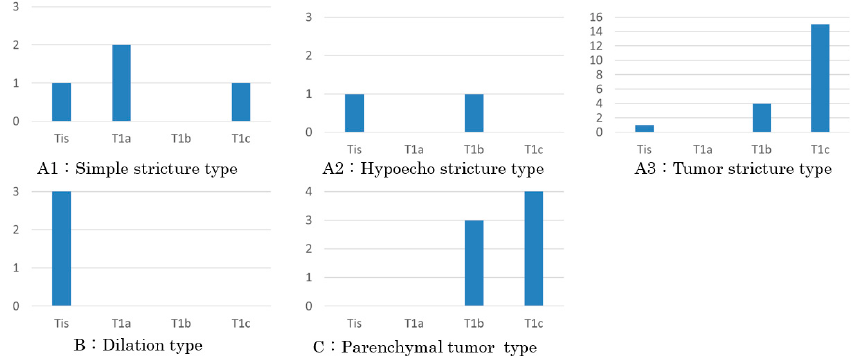
Figure 3. T category of the lesions. Categories ( A1) and ( A2) without an obvious tumor include carcinoma in situ (CIS) and invasive carcinoma. Two of the three invasive carcinomas of A1 were T1a. ( A3 ) and ( C ) with a detectable tumor almost consist of T1b and T1c. Every carcinoma of ( B ) showing pancreatic duct dilation without a downstream stricture is CIS.